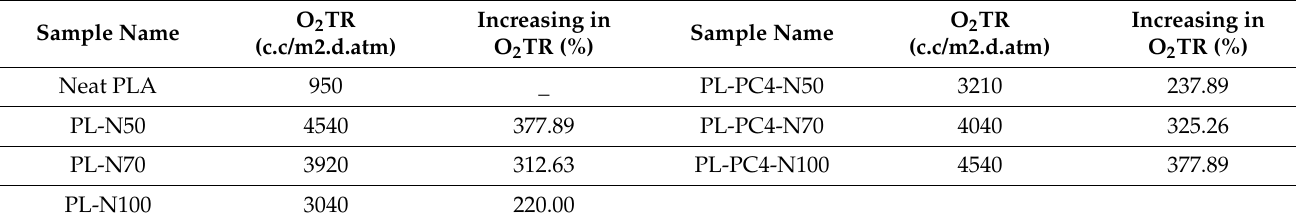
Table 5. Oxygen transmission rates (O 2 TR) of neat PLA and porous PLA and PCL/PLA